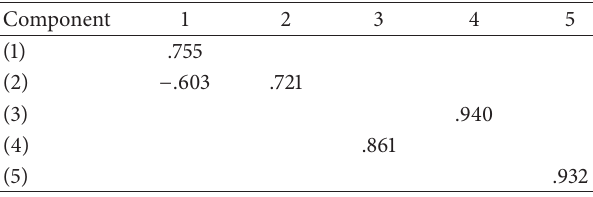
Table 3: Component transformation matrix of the ASDA.